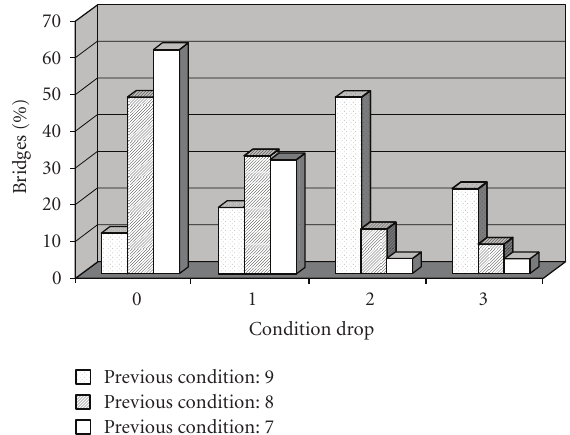
Figure 2: Trend of bridges deck condition deterioration for bridges in “Good” deck condition state.